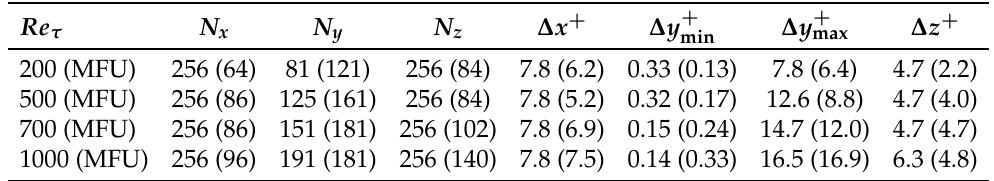
Table 1. A summary of grid systems and resolutions for extended domain and minimal flow unit (MFU)